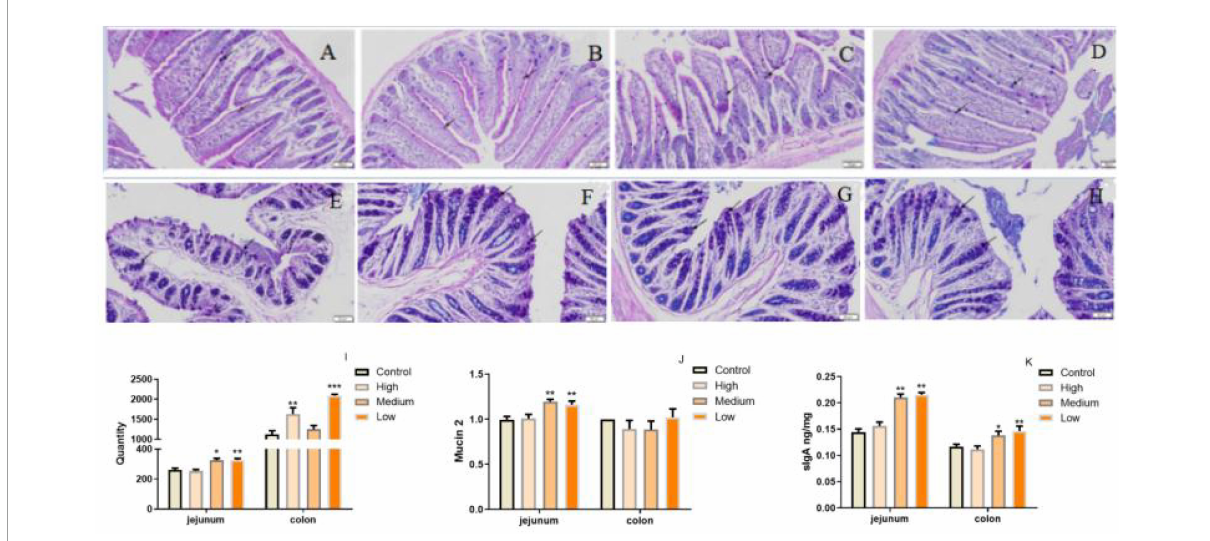
FIGURE6 PSP-NP enhances the intestinal immunity of aged mice. (A–D) AB-PAS stain of jejunum in the control, high, medium and low dose groups, respectively. Arrows indicated the goblet cells. It showed the goblet cells in jejunum treated with different doses of PSP-NP. Bar: 200 µ m. (E–H) AB-PAS stain of colon in the control, high, medium and low dose groups, respectively. Arrows indicated the goblet cells. It showed the goblet cells in colon treated with different doses of PSP-NP. Bar: 200 µ m. (I) The goblet cell count of jejunum and colon in the control, high, medium and low dose groups, respectively, it showed the goblet cells increased as the concentrations of PSP-NP increased and showed remarkable changes in the high group. N = 4. (J) The Gene expression of Mucin 2 in jejunum and colon was measured by qRT-PCR. The quantification showed that PSP-NP up-regulated gene expression of Mucin 2 in jejunum, there is no significant effect in the colon. N = 4. (K) The content of sIgA in jejunum and colon was analyzed by ELISA. PSP-NP improved the content of sIgA ( µ g/mg) in the jejunum and colon in the medium and high dose groups. N = 8. Error bars indicated SEM. All data were analyzed by SPSS with the one-way analysis of variance (ANOVA) by LSD test, * P < 0.05, ** P < 0.01, *** P < 0.001, compared with a control